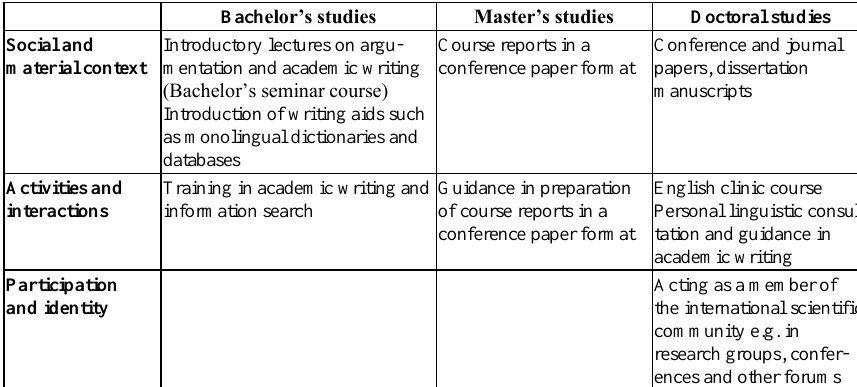
Table 2. Actions supporting students’ situated learning of academic writing at different